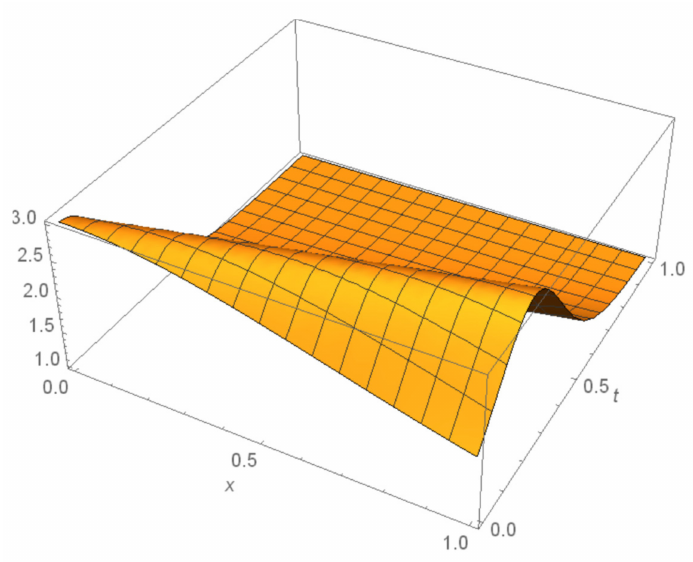
Figure 11. 3D plot of exact solution.